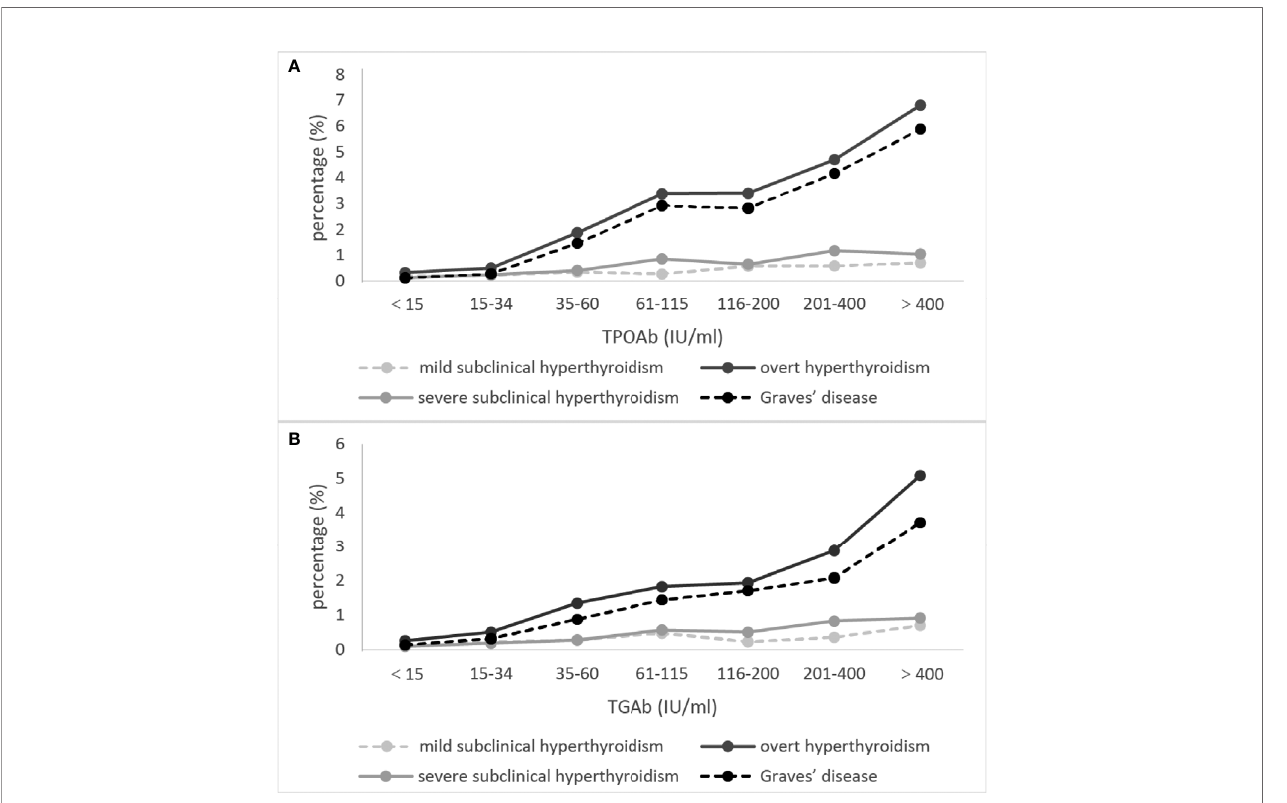
FIGURE 3 | The proportion of subjects with overt hyperthyroidism and Graves ’ disease at different autoimmune antibody levels. (A) refers to TPOAb, (B) refers to TgAb. Mild subclinical hyperthyroidism [thyroid-stimulating hormone (TSH) 0.1 – 0.26 mIU/L, free thyroxine (fT3) and free triiodothyronine (fT4) within the normal range]. Severe subclinical hyperthyroidism (TSH <0.1 mIU/L, fT3 and fT4 within the normal range). The concentrations of thyroid autoimmune antibodies (TPOAb and TgAb) were strati fi ed by gradient in accordance with